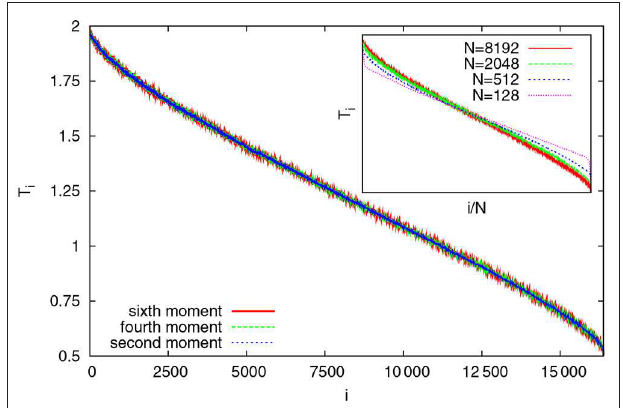
FIGURE 5 | FPUT- β model: Kinetic temperature profile for a system with N 16384, T ℓ 2.0, T r 0.5. Assuming a Gaussian local velocity = = = distribution, the temperatures as defined from the first three even moments are shown; their agreement vindicates the assumed Gaussian velocity distribution. (Inset) Normalized temperature profiles for different N (adapted from Mai et al. with permission from [10] Copyright (2007) by American Physical